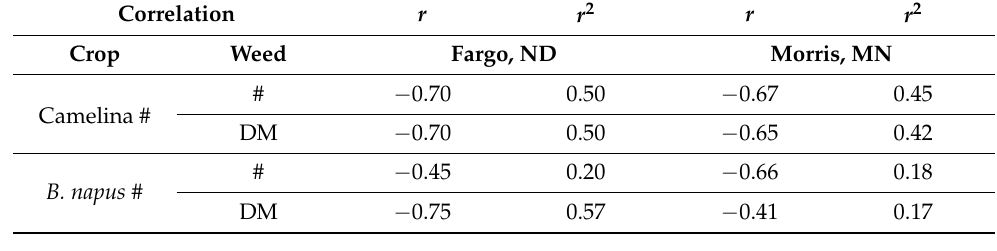
Table 3. Regression analysis and correlation between crop plant density (#) and weed density (#) and dry matter biomass (DM) at Fargo, ND and Morris, MN. Correlation r r 2 r 2